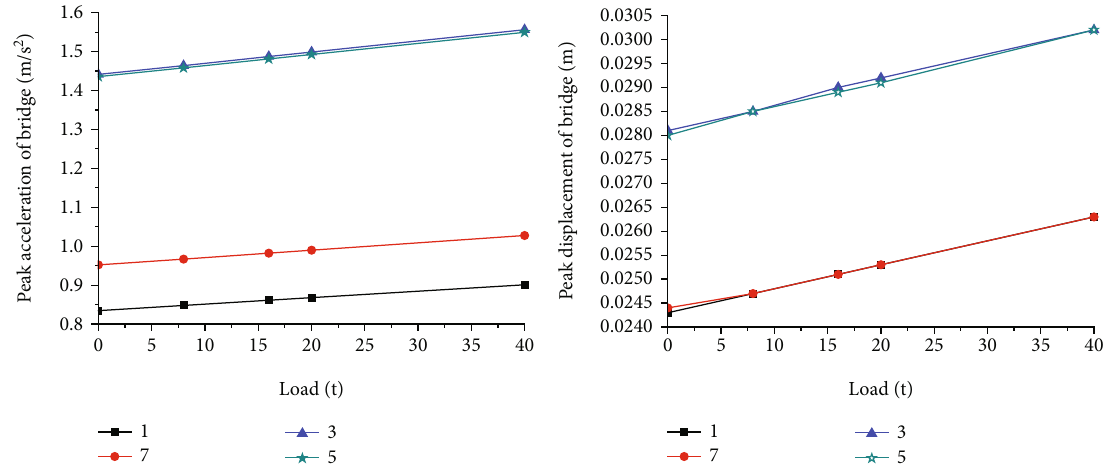
Figure 6: Peak acceleration of each node under di ff erent